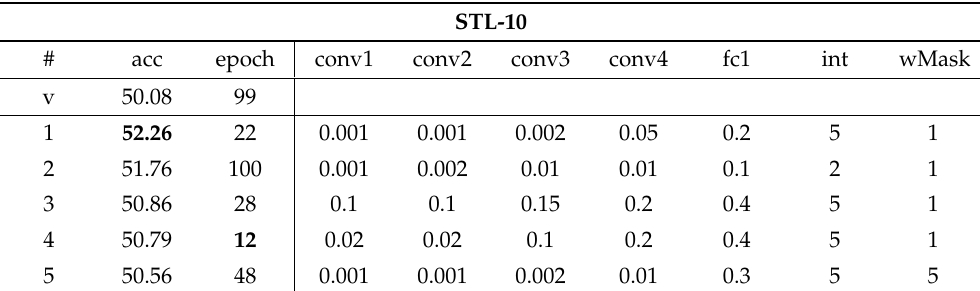
Table 4. Accuracy scores, parameter tuning, and convergence times for different experiments on the STL-10 dataset. The first row holds the best accuracy score for the vanilla dropout version and the epoch at which it was attained.